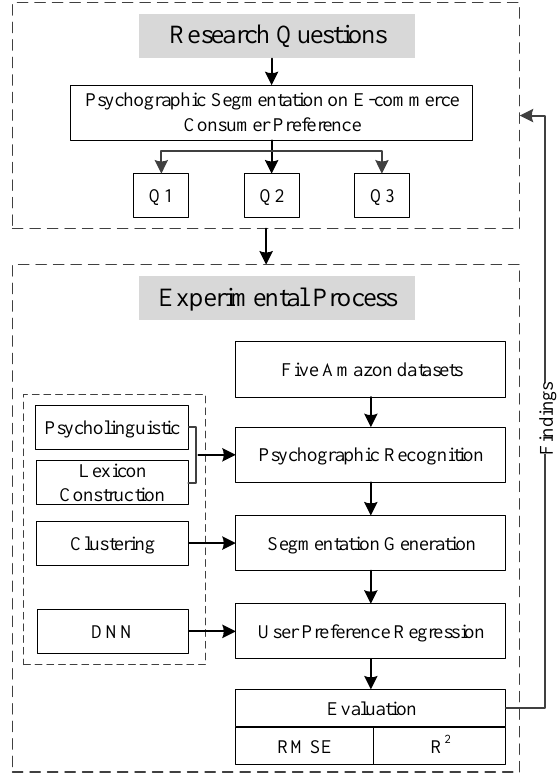
Figure 2. Research framework.